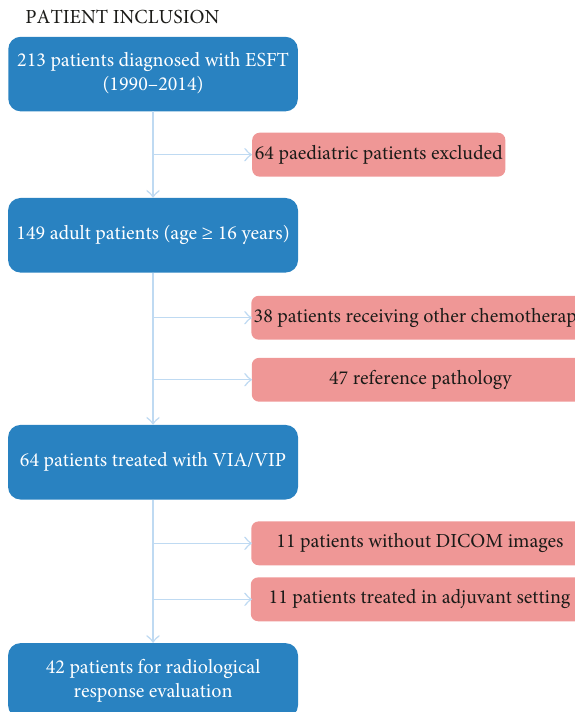
Figure 2: Inclusion of patients with diagnosis of ESFT treated in our hospital, aged 16 years and older, and treated with